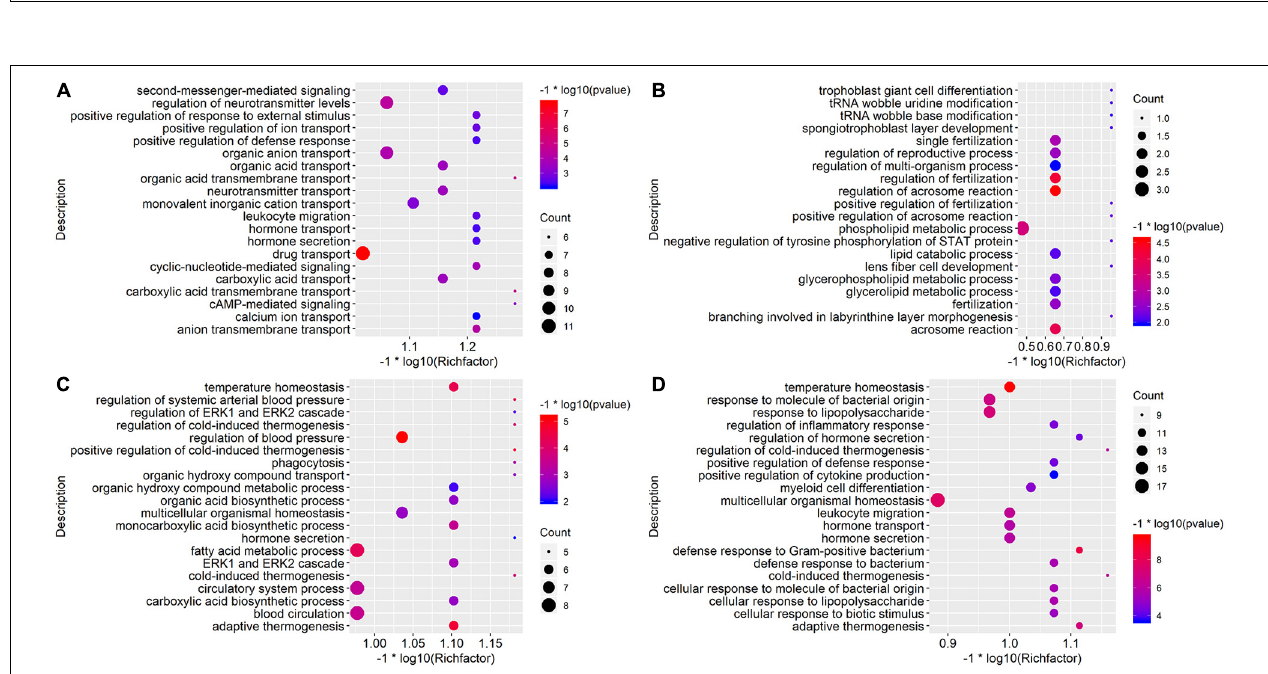
FIGURE 3 | Gene Ontology (GO) enrichment analysis of down-regulated DEGs in comparison groups. The top 20 significant Biological Processes terms of down-regulated DEGs in D10NTC vs. D10TOA group (A) , top 20 significant Biological Processes terms of down-regulated DEGs in D10NTC vs. D20TOA group (B) , top 20 significant Biological Processes terms of down-regulated DEGs in D30NTC vs. D30TOA group (C) , and top 20 significant Biological Processes terms of down-regulated DEGs in D30NTC vs. D35TOA group (D) . Size and color of the bubbles are measured as count and p- value to represent the amount of DEGs enriched in these terms and the enrichment